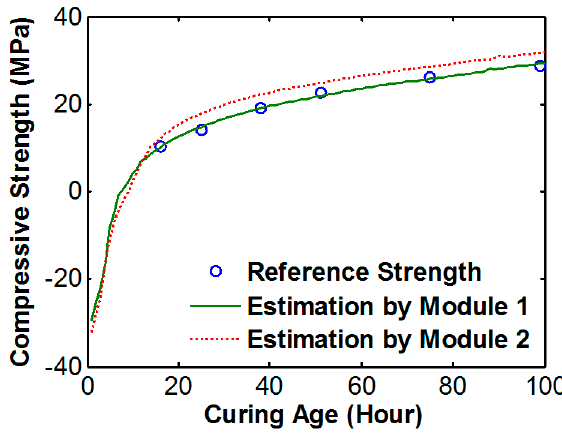
Figure 9. Strength estimation result using the regression model.